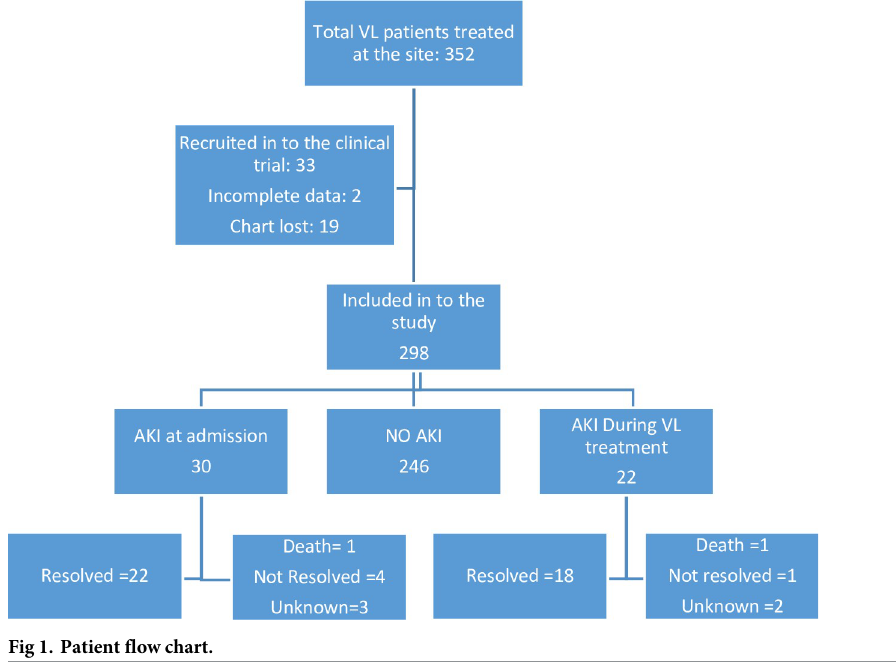
Fig 1. Patient flow